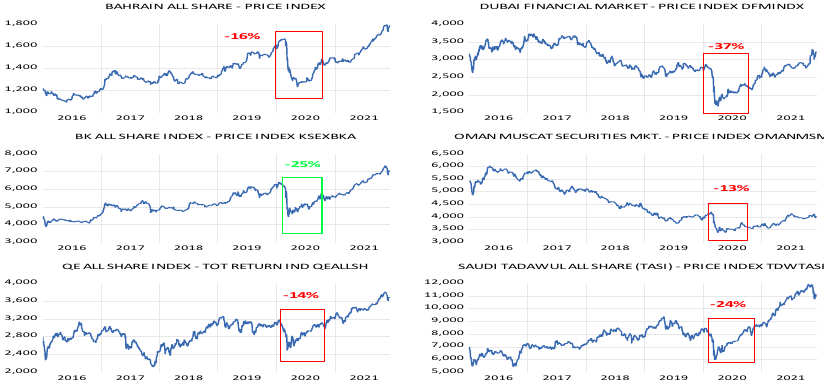
Figure 3. E7 Stock Markets Decline amidst the COVID-19 Pandemic. Note: The figure highlights the lowest points reached by the E7 leading stock markets recorded on 23 March 2020. Source: DataStream (2021). Figure 4 below highlights the effects of the global health crisis on the performance of the GCC markets. Aligned with the outcomes for the G7 and the E7 markets, significant price drops were recorded on 23 March 2020. The Dubai index (DFMGI) was the most impacted as it dropped by 37%, followed by the Kuwaiti index (KSE), which dropped by 25%, followed by the Saudi index (TASI), which fell by 24%. On the other hand, the Bahrain index (Bahrain), Qatar index (Qatar) and Oman (Muscat) recorded the lowest impact with drops of 16%, 14% and 13%, respectively.